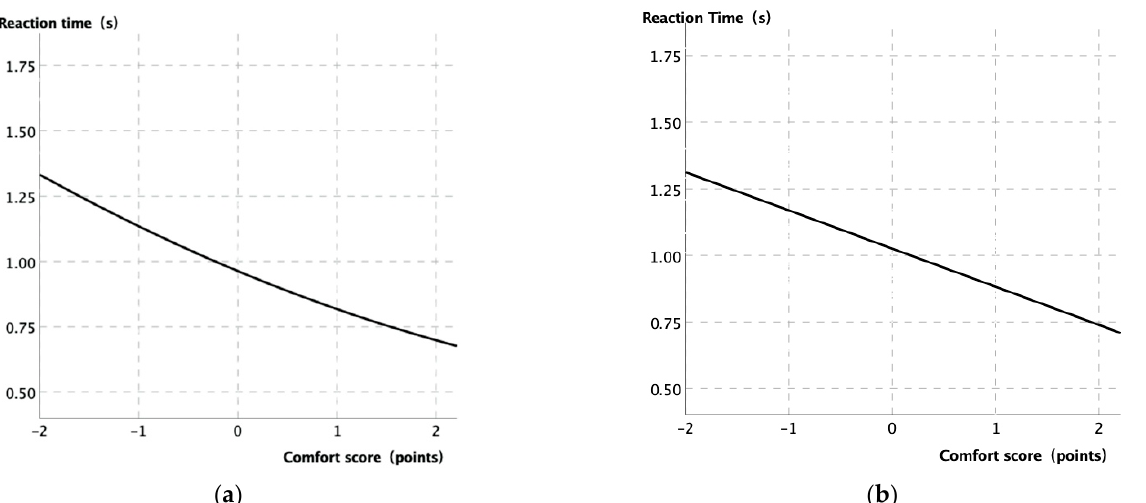
Figure 9. Regression curves of reaction time and comfort scores for men and women. ( a )Regression curves of reaction time and comfort scores in men. ( b ) Regression curves of reaction time and com- fort scores in women.